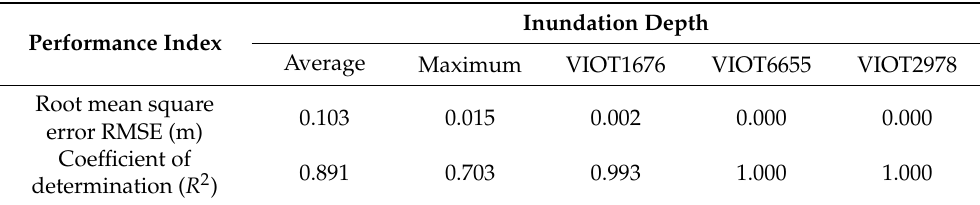
Table 6. Performance indices of the resulting inundation-depth estimates from the proposed SM_EID_VIOT model.